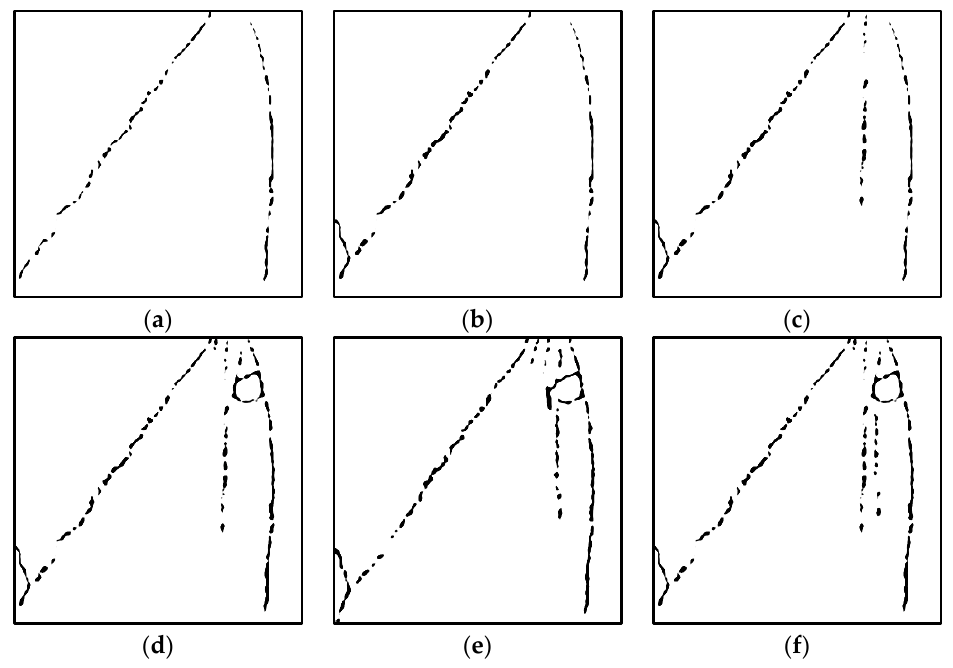
Figure 11. Static images of cracks during the shale destruction process. ( a ) Crack initiation stage; ( b – d ) crack propagation stage; ( e ) crack penetration stage; ( f ) overall failure stage. Table 3. Stress and strain values corresponding to the crack static images. Crack No.